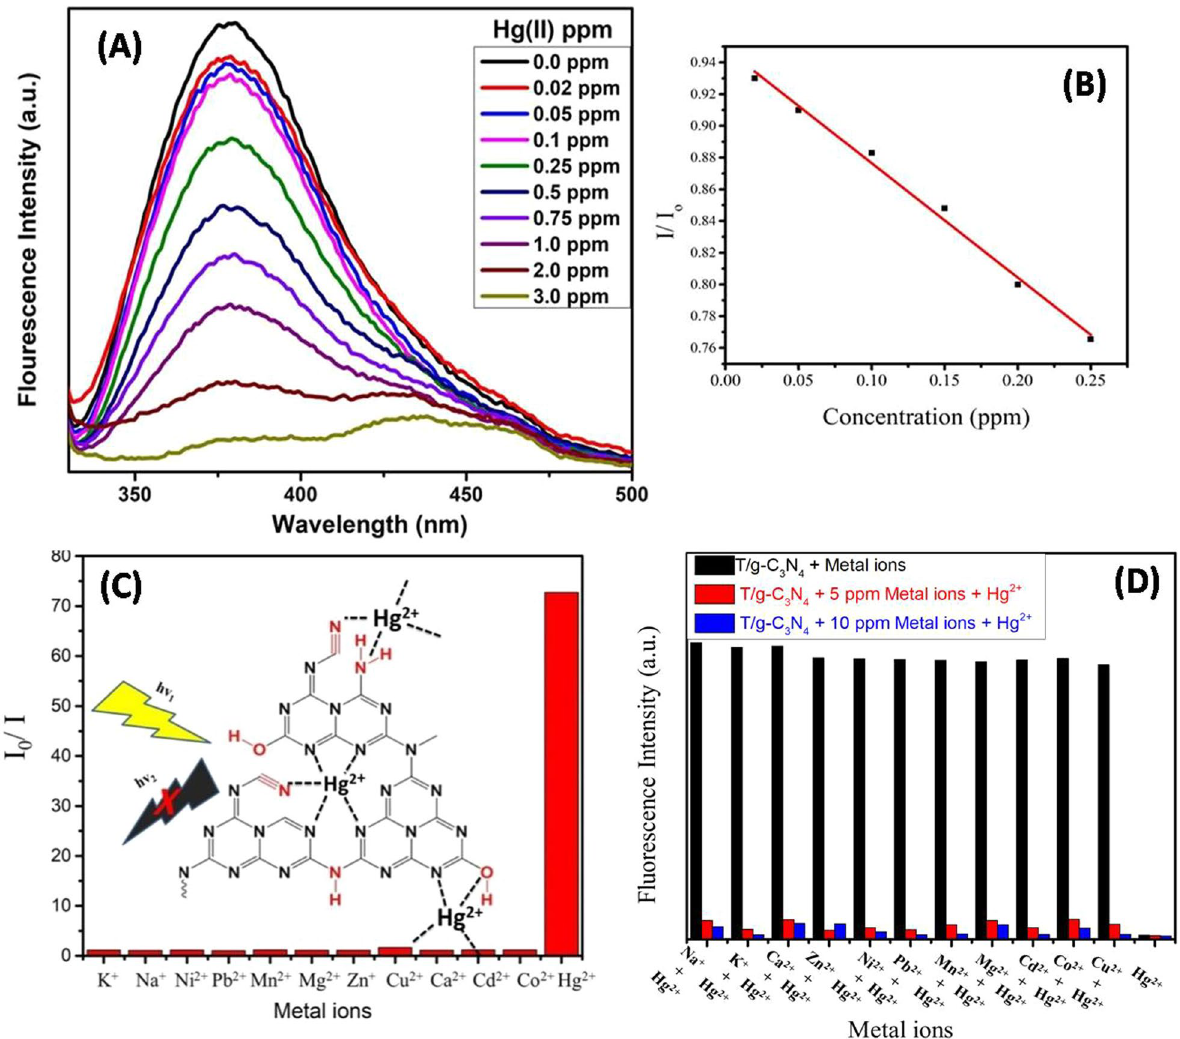
Fig. 5 A Fluorescence emission spectra of T/G‑C 3 N 4 in 0.01 M phosphate buffer (pH 6.0), with Hg 2 + at various concentrations (0–3.0 ppm), = T/G‑C 3 N 4 at 3.0 mg/L, reaction time at 5 min, and excitation at 290.0 nm. B The linear relationship between Hg 2 + concentration and emission intensities. C Selectivity of T/G‑C 3 N 4 (3.0 mg/L) for various metal ions at a concentration of 3.0 ppm (where I and I 0 represent the fluorescence intensities of T/G‑C 3 N 4 in the presence and absence of metal ions, respectively) and the red colored atoms refer to the new bonds (OH, NH 2 , NH X , and CN groups) formed onto the surface of G‑C 3 N 4 due to the partial deprotonation of melon units after thermal alkali treatment. D Fluorescence responses of T/G‑C 3 N 4 to competing metal ions (5.0 mg/L) black bars to Hg 2 + ions (3.0 ppm, red and blue bars), in 0.01 M phosphate buffer (pH 6.0), T/G‑C 3 N 4 (3.0 mg/L), excitation at 290 = =